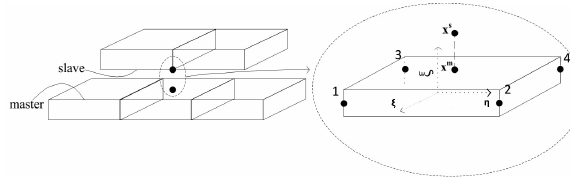
Figure 5: Projection of slave node to master surface.